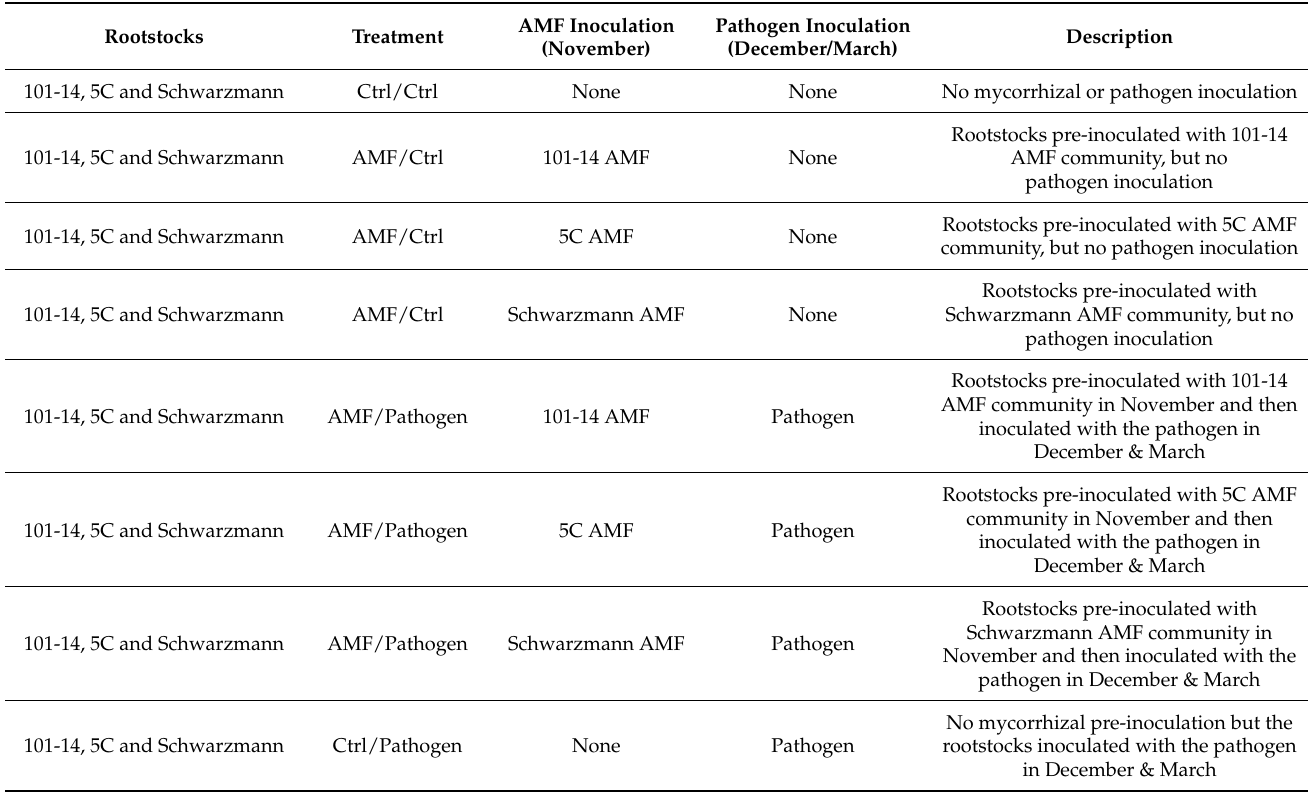
Table 1. Inoculation treatments applied to three grapevine rootstocks. The fungal inoculants con- sisted of “home” and “away” AMF communities, and black foot pathogen mixture. Treatment codes are as follows: Ctrl = no microbial inoculation, AMF = Arbuscular mycorrhizal fungi inocu- lation, Pathogen = black foot inoculation. The pathogen treatment was inoculated both at planting (December) and three months later in